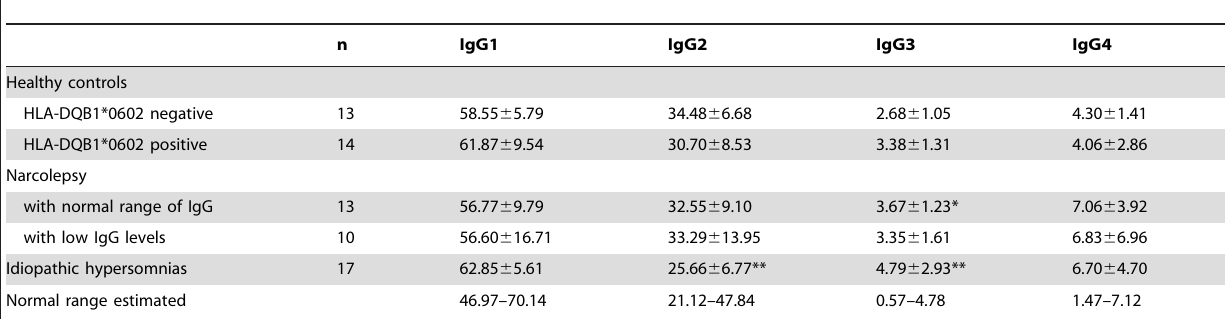
Table 3. The proportion of each IgG subclass in total IgG